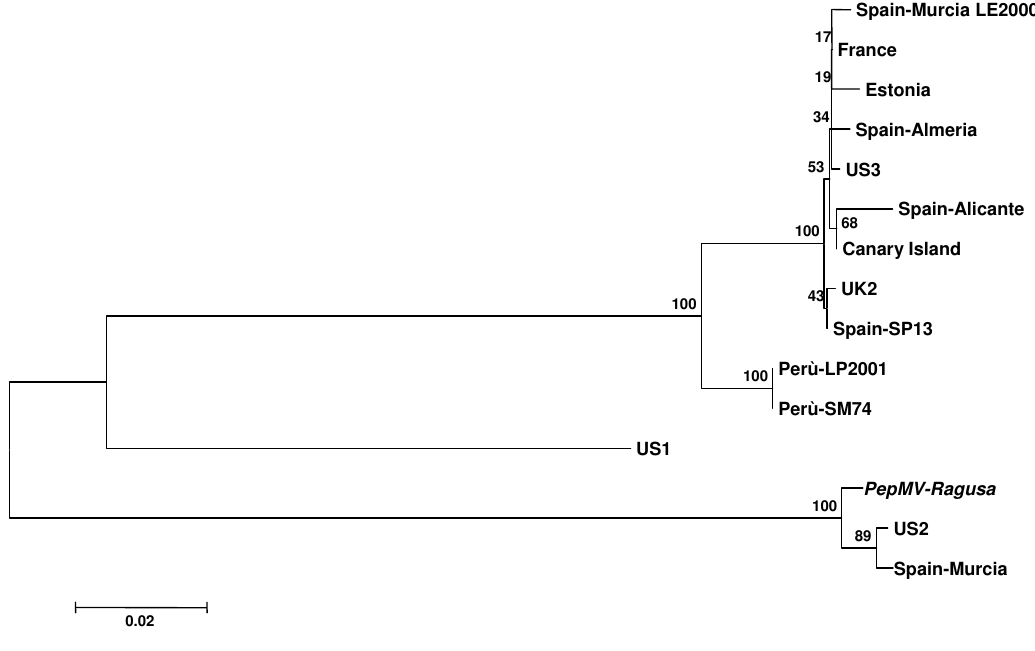
Fig. 1. Bootstrap consensus trees of CP of PepMV- Ragusa complete sequence, constructed with the MEGA program according to the neighbour-joining method. Bootstrap values (percentages) are indicated in the nodes; strain acronyms are as in the